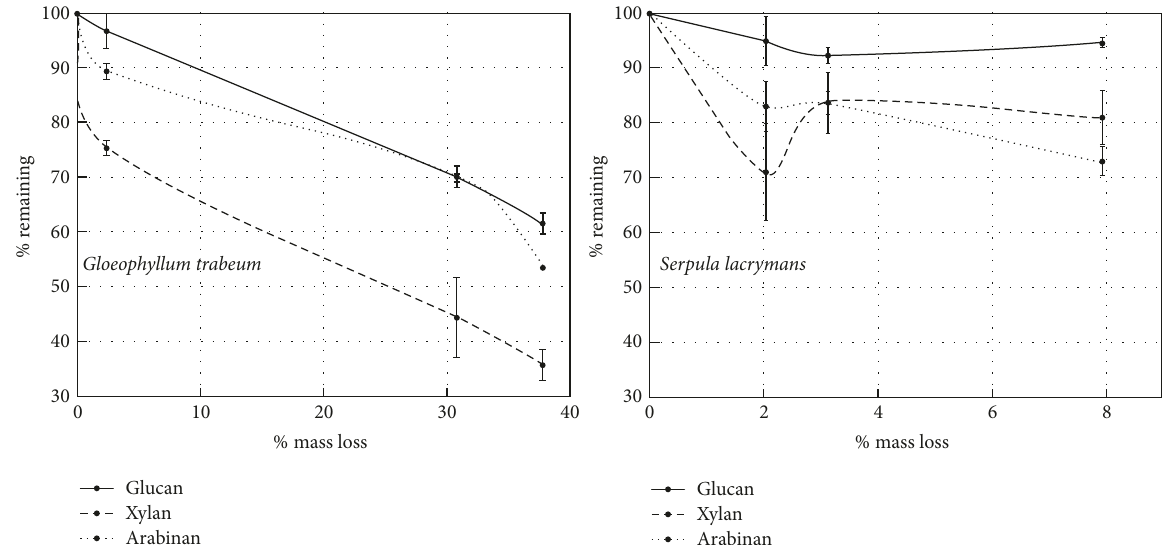
Figure 1: Major structural carbohydrate removal from sorghum biomass over a 21-day progression of decay for Gloeophyllum trabeum and Serpula lacrymans . Error bars are +/ − standard error of three replicate assays of each of the two replicate